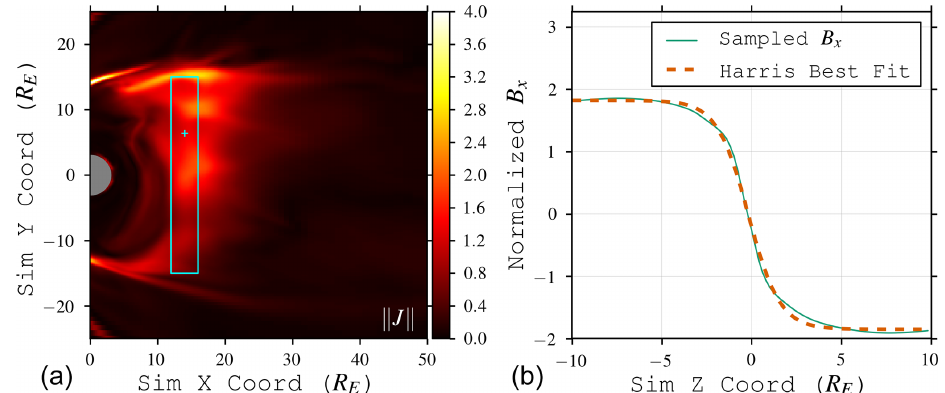
Figure 7. Example of B x sampling and Harris sheet fit (b) as described in text (Eq. 11). χ 2 = 0 . 004 for this fit. B x has been normalized via B w = 10 − 4 G. Panel (a) shows the magnetotail current sheet magnitude (normalized via J 0 = B w /L 0 ) in the simulation z = 0 plane; the B x sampling box domain boundaries are shown in cyan, with the small cross showing the location of the example sample. The box boundaries are 12 < x < 16 and − 15 < y < 15.